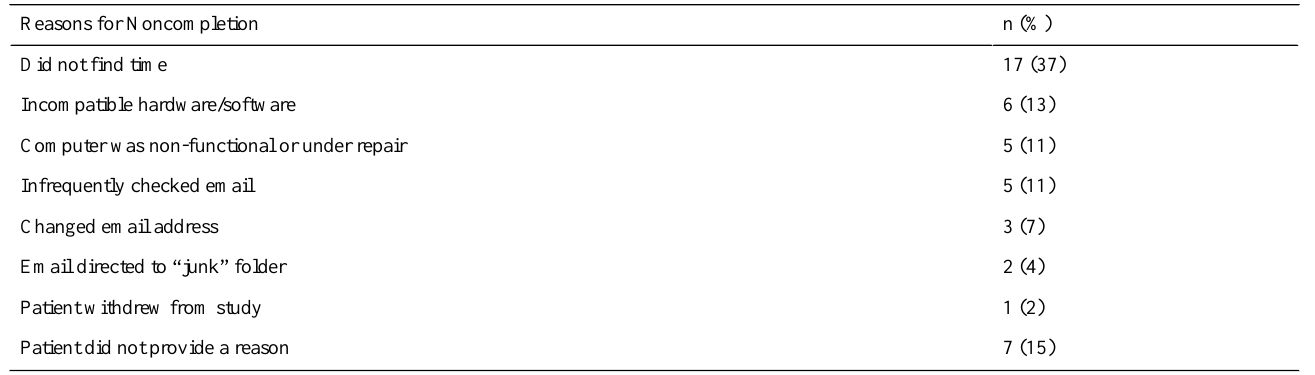
Table 5. Reasons for noncompletion of home HRQOL questionnaires over the Internet (n =